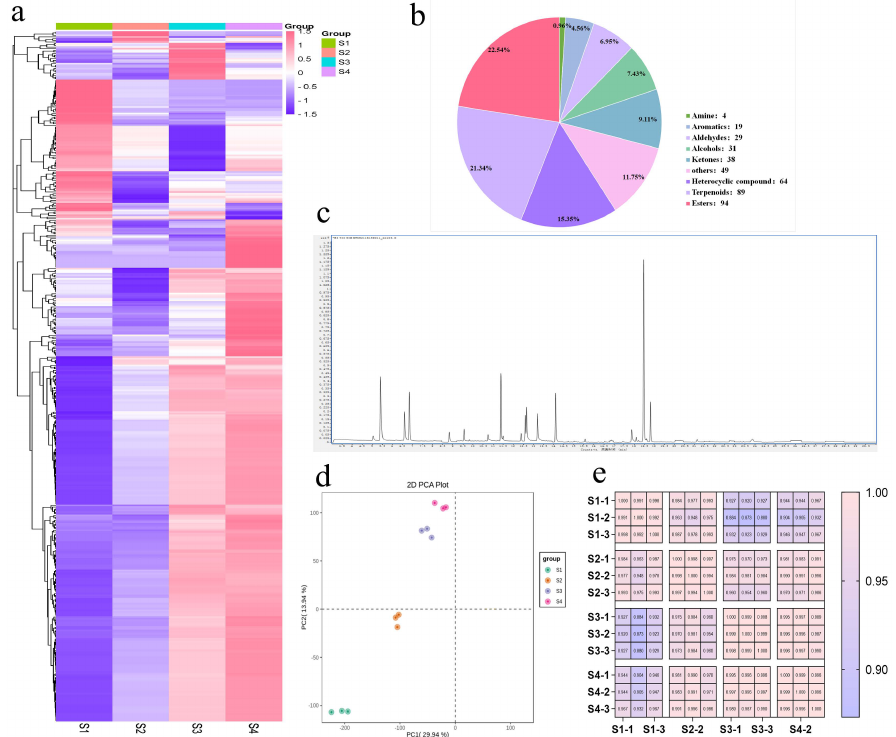
Figure 2. Heat map, TIC, PCA, and correlation coefficient for relative VOC differences at the four stages. ( a , b ) Clustering heat map of all VOCs. ( c ) Overlay of the QC sample mass detection TIC plot. ( d ) PCA score plots showing high cohesion within groups and good separation among the four stages. Quality control in the mixed sample. ( e ) Correlation